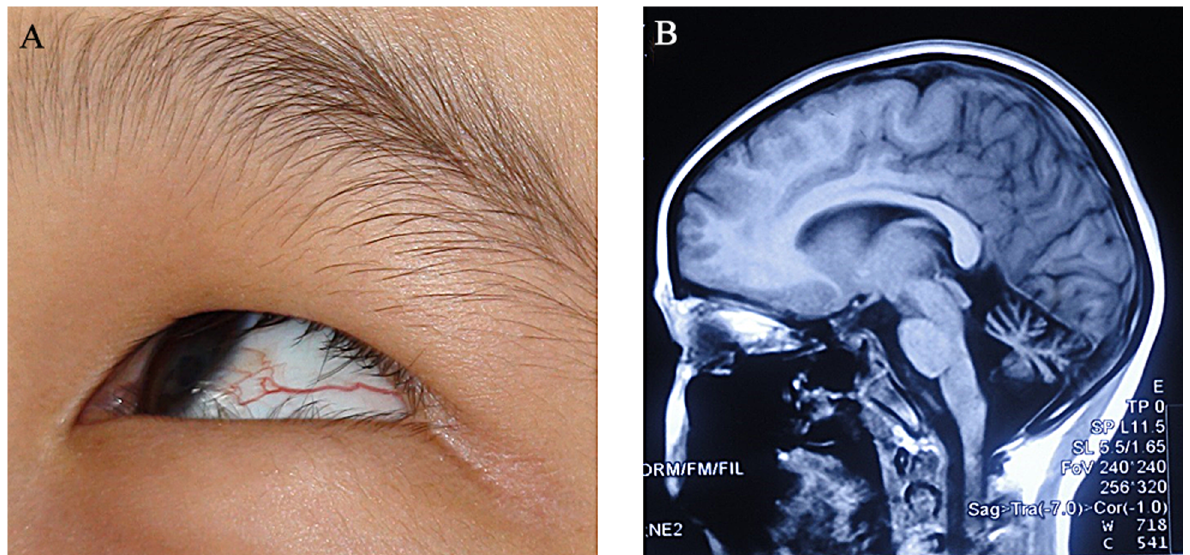
Fig 1. The clinical features of an AT patient. Ocular telangiectasia (A) and cerebellar atrophy revealed on brain MRI (sagittal T1) (B) were indicated in a proband (FAT – 2 pedigree) with AT.